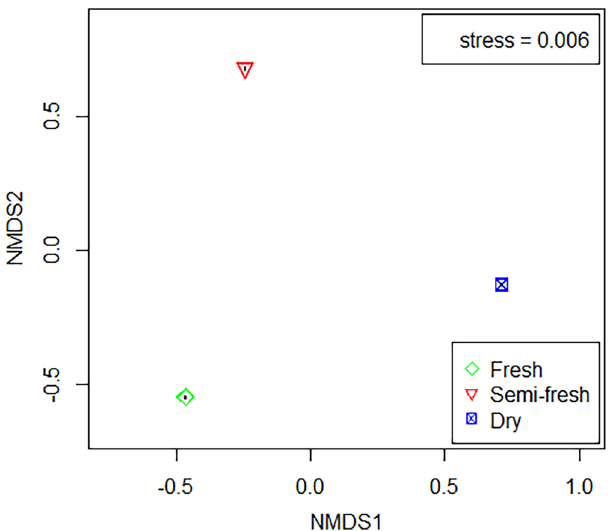
Figure 4. Multivariate analysis of the volatiles from feces of Przewalski’s horse with the three different freshness states at the OVIP stage of Gasterophilus pecorum by the non-metric multidimensional scaling (NMDS) method. Fresh, Semi-fresh, and Dry represent fresh, semi-fresh, and dry feces at the oviposition (OVIP) stage of Gasterophilus pecorum ,